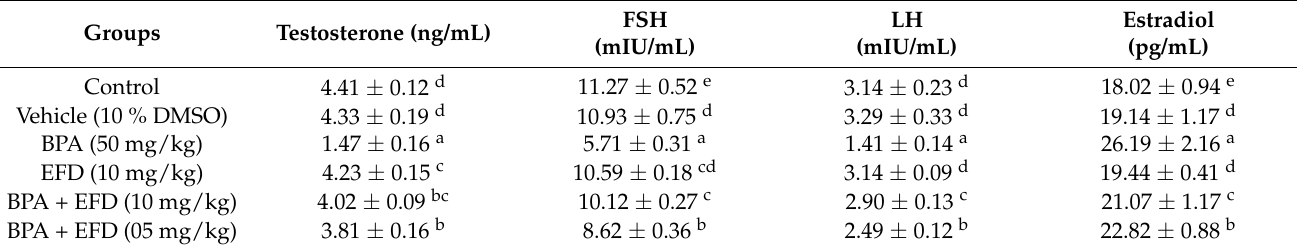
Figure 5. Histological assessment of the protective efficacy of EFD on rat testes. Note: 40 × Hematoxylin-eosin stain. ( A ) Control, ( B ) Vehicle, ( C ) BPA ( D ) EFD (10 mg/kg) ( E ) BPA + EFD (10 mg/kg) ( F ) and BPA + EFD (5 mg/kg). Table 4. Appraisal of reforms to hormonal levels by